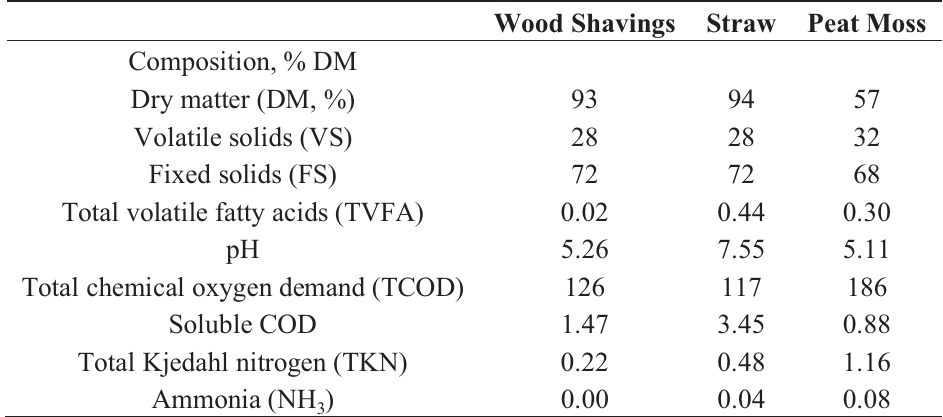
Table 4. Composition of the bedding types used to assess fugitive methane emissions from slurry with bedding at 20